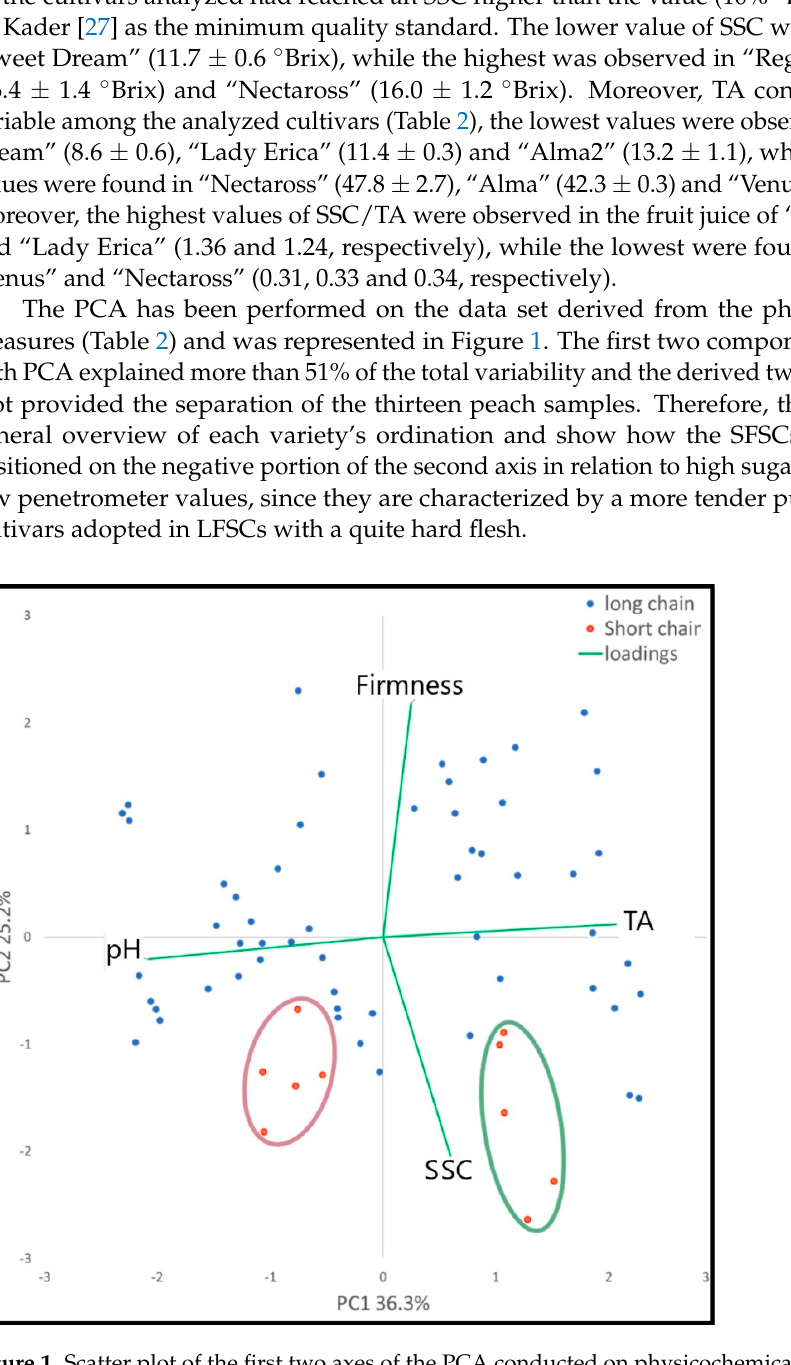
Figure 1. Scatter plot of the first two axes of the PCA conducted on physicochemical measures. Red circle highlights the “Guglielmina” samples; the green circle the “Regina di Londa” samples. In fact, “Regina di Londa” and “Guglielmina” are two traditional varieties not used